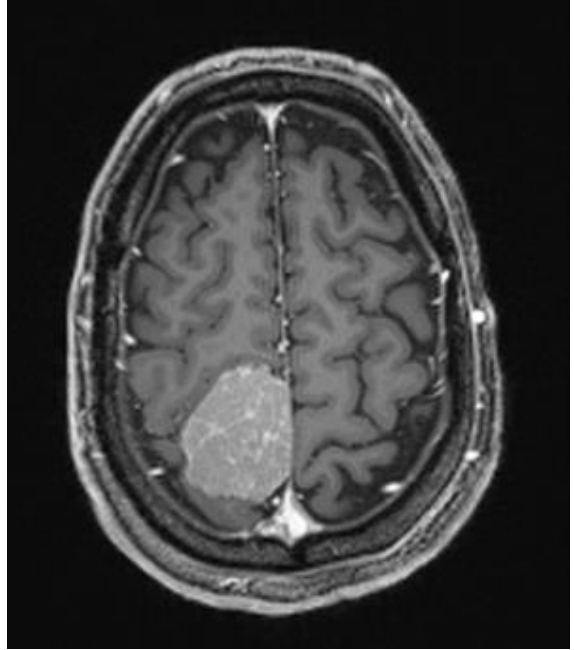
Figure 1. Axial view magnetic resonance image of the